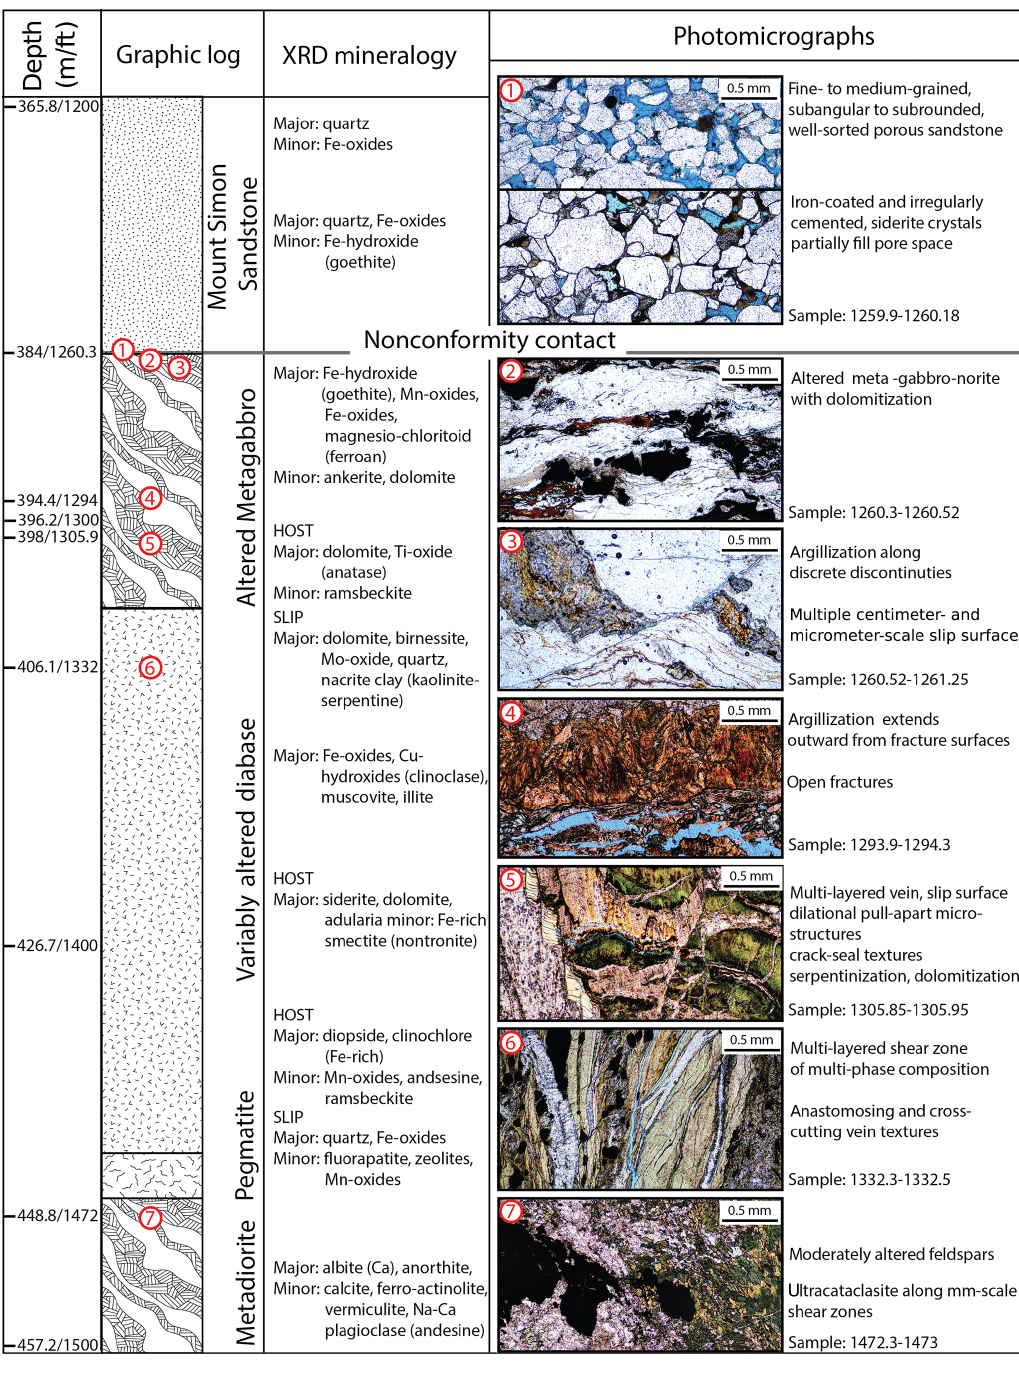
Figure 11. X-ray diffraction mineralogy and photomicrographs of BO-1 drill core samples showing representative compositions and textures across the nonconformity interface contact. Samples within centimeters of the contact (1–3) are strongly weathered, altered, and slightly metamorphosed gabbro-norite. Alteration and diagenesis assemblages include iron-oxide hydroxides with chlorite, ankerite, and dolomite. Alteration extends for ∼ 50m into the basement. Sample 3 illustrates millimeter-scale offset across the argillite layer. Note the fracture permeability (blue epoxy) parallel to the slip surface. Fracture surfaces within Sample 4 at 34m below the contact are several millimeters of mixed chlorite–clay alteration and fine-scale permeability (blue epoxy). Sample 5 at 1304.9m shows multiple phases of fluid–rock in- teractions coupled with dilation, serpentinization, and dolomitization. There is a multi-layered clay-rich fault core gouge within Sample 6 at 1332m or ∼ 70m below the contact. Note the open fractures within the central portion of the fault core gouge (blue epoxy). At 1472 or 272m below the contact within the meta-grano-diorite unit, clay alteration is observed within feldspar grains at the